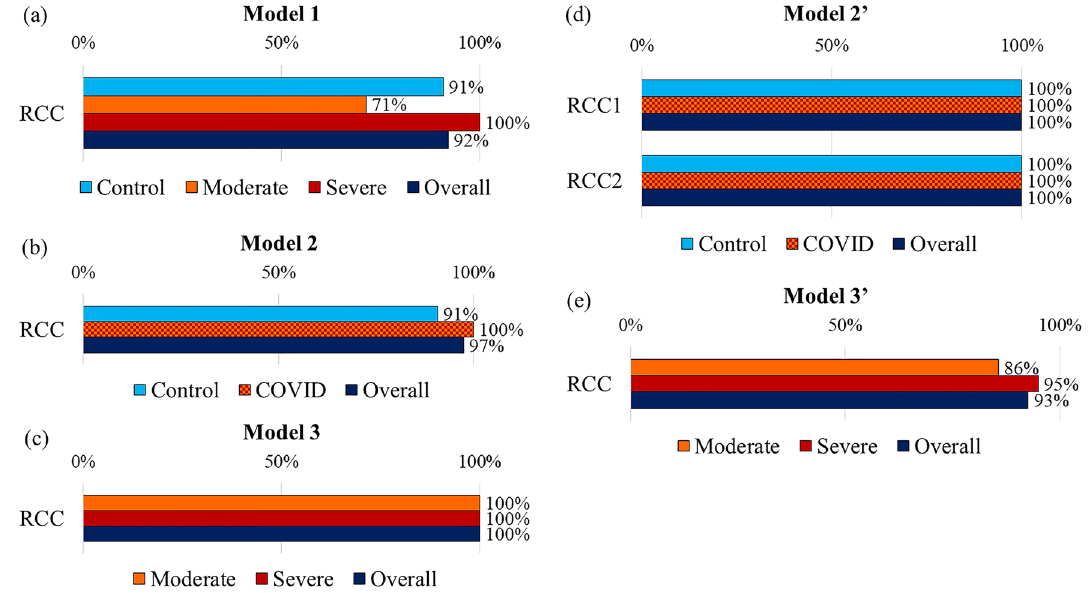
Figure 2. Rate of correct classification (RCC) based on the discriminant models (models 1, 2, and 3) and binary logistic regression models (models 2 ′ and 3 ′ ). ( a ) RCC for Model 1, distinguishing between healthy volunteers (n = 11), the moderately ill (n = 7), and the severely ill (n = 20) COVID-19 patients. ( b ) RCC for Model 2, distinguishing between healthy volunteers (n = 11) and COVID-19 patients including moderately and severely ill patients combined in one group (n = 27). ( c ) RCC for Model 3, distinguishing between moderately (n = 7) and severely ill (n = 20) patients. ( d ) RCC for Model 2 ′ , distinguishing between healthy volunteers (n = 11) and COVID-19 patients (n = 27). ( e ) RCC for Model 3 ′ , distinguishing between moderately (n = 7) and severely ill (n = 20) patients. RCC1 and RCC2 in Model 2 ′ are the RCCs for steps 1 and 2 of the logistic regression models,